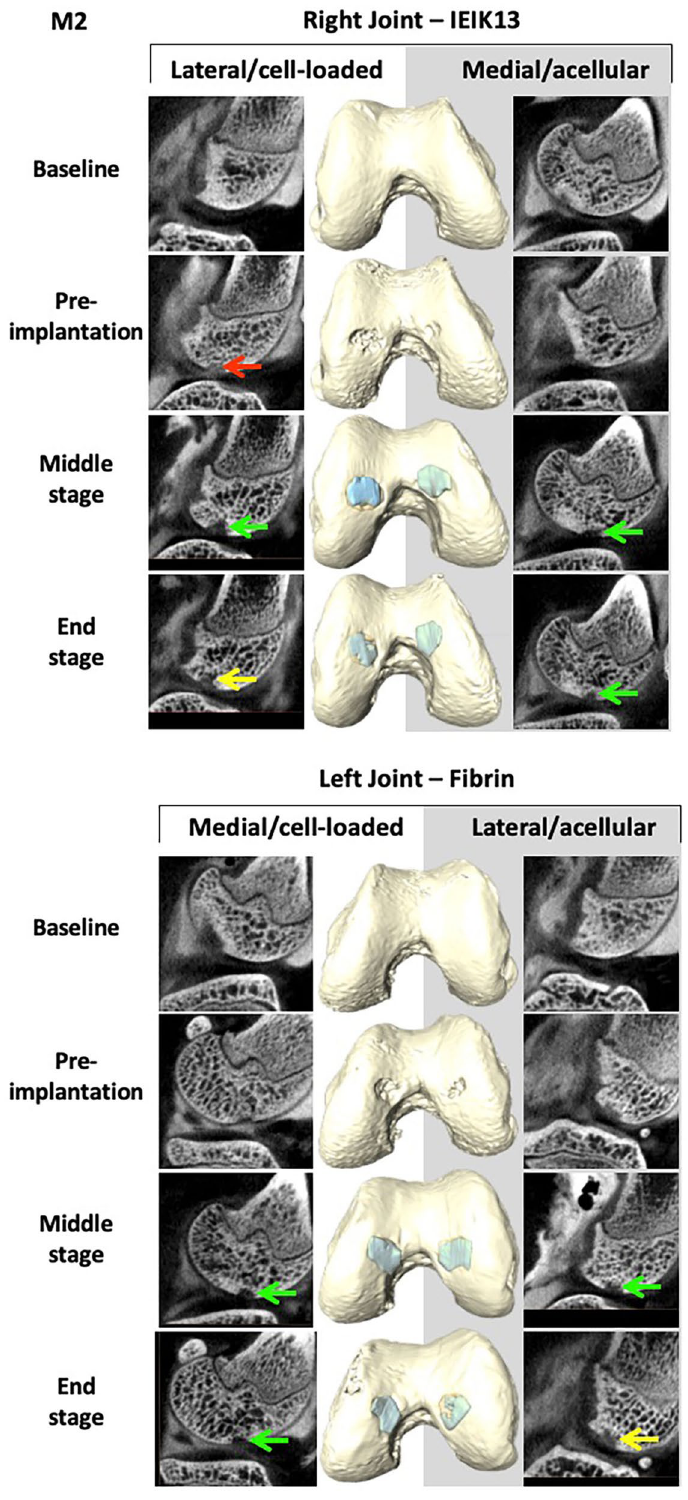
Figure 5. Non-invasive monitoring of IEIK13- and fibrin-based hydrogels implanted in M2 monkey. The hydrogels were loaded or not with cells, as indicated. The site of implantation in knee joint is specified. Examples of segmented CECT images (left and right panels) and 3D surface reconstruction (middle panel) corresponding to different stages of the study: 3 days before first surgery (baseline), 6 days before removal of the scar tissue and implantation (pre-implantation), 41 days after implantation (middle-stage) and 82 days after implantation (end- stage). The red arrow shows complete filling of the defect by the contrast agent (observed as grey cloud). The yellow arrows show heterogeneous diffusion of the contrast agent. The green arrows show absence of contrast agent, indicating occupancy of the corresponding regions by the